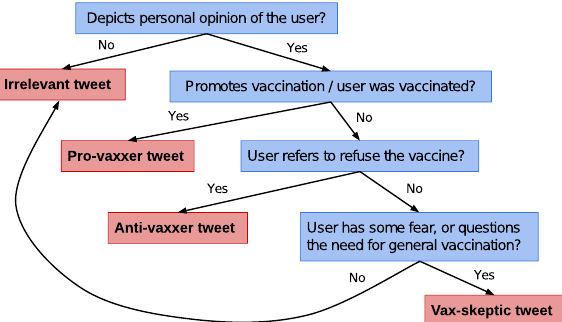
Fig. 5 Definition for vaccine view categories that we used during the tweet labeling process. In Table 1,